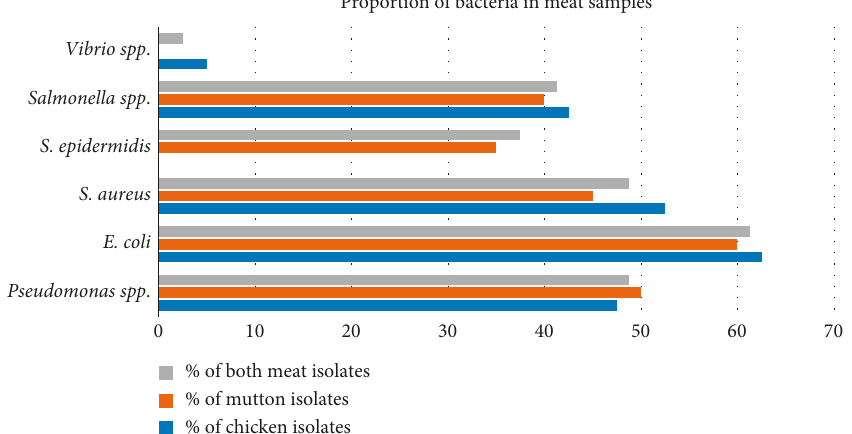
Figure 3: Proportion of bacteria in meat samples.